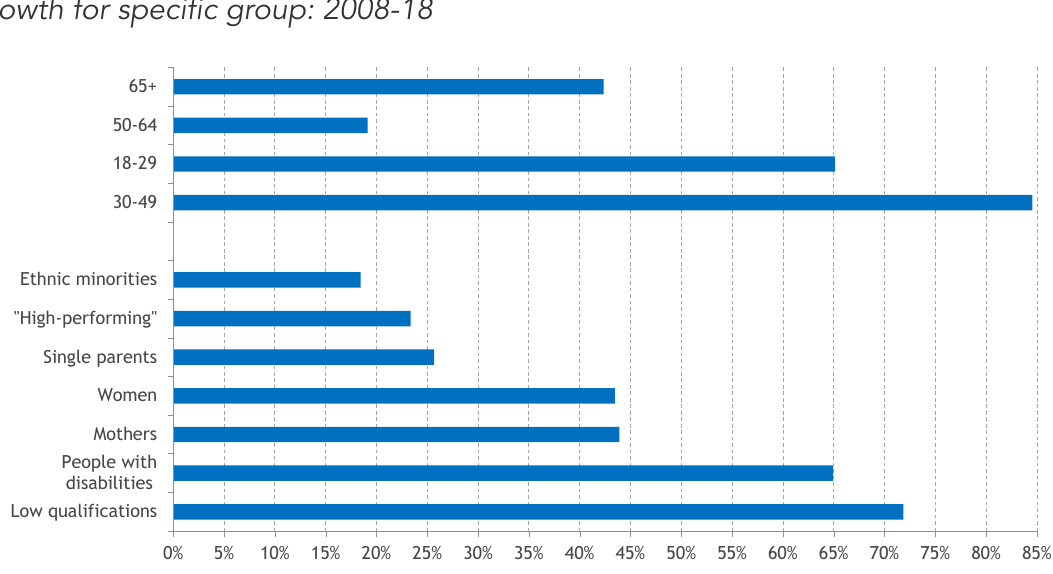
Figure 11: The relationship between improvements in the overall employment rate and changes for specific groups is stronger for some groups than for others Strength of relationship (R-squared) between overall employment rate growth and growth for specific group: